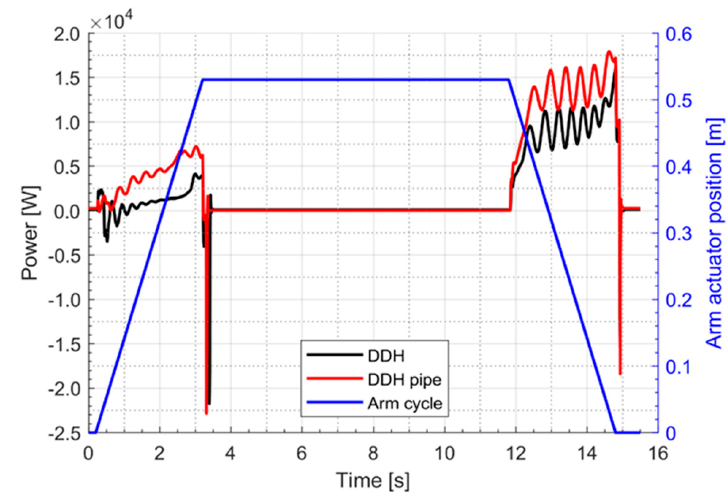
Figure 11. Electric motor power arm actuator—DDH and DDH with pipes.